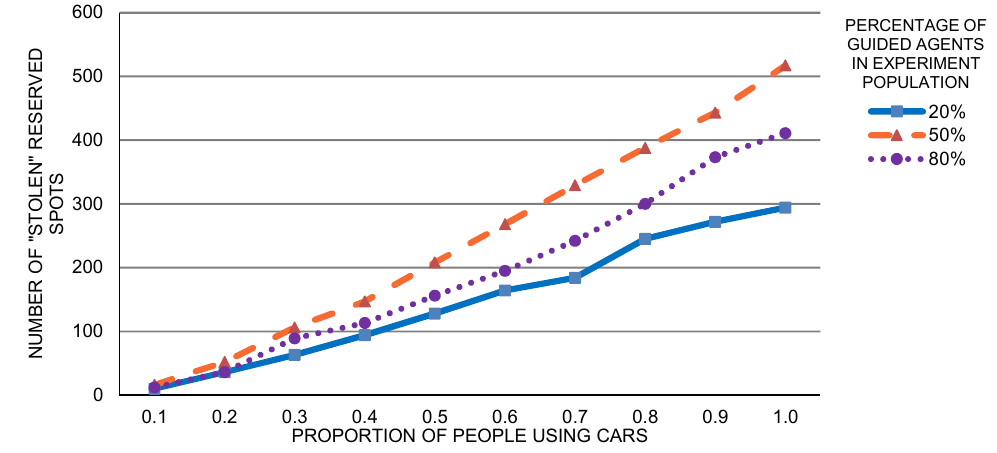
Figure 8. The reservation guarantee problem, explored for several levels of parking demand and agent types